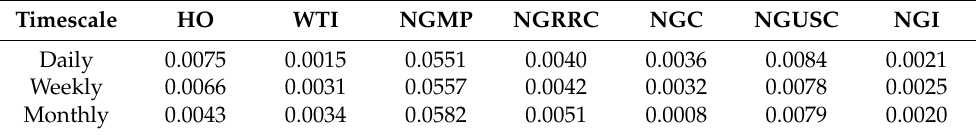
Table 3. The importance degree of seven explanatory